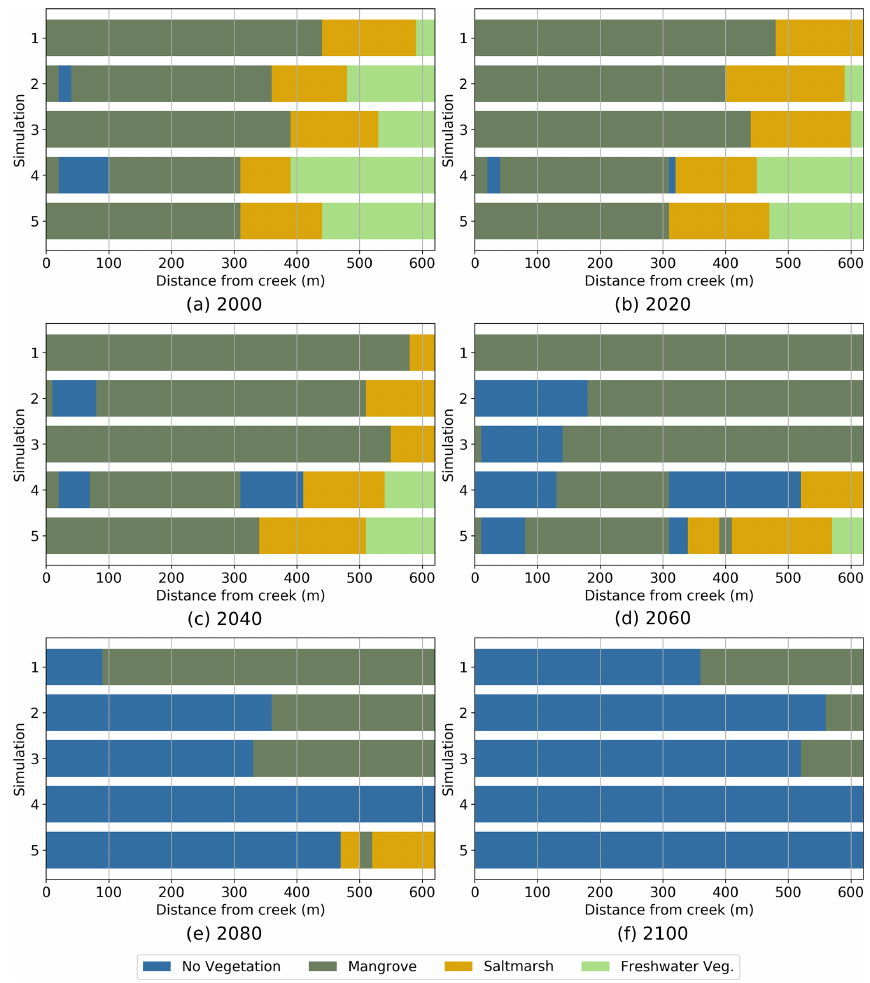
Figure 5. Predominant position occupied by each vegetation type in the tidal flat from 2000 to 2100. Simulations for low sediment input, SSC = 37gm − 3 . Simulations: 1 Bathtub, 2 Free tidal flat, 3 Inner channel, 4 Embankment with culvert and 5 Embankment and inner